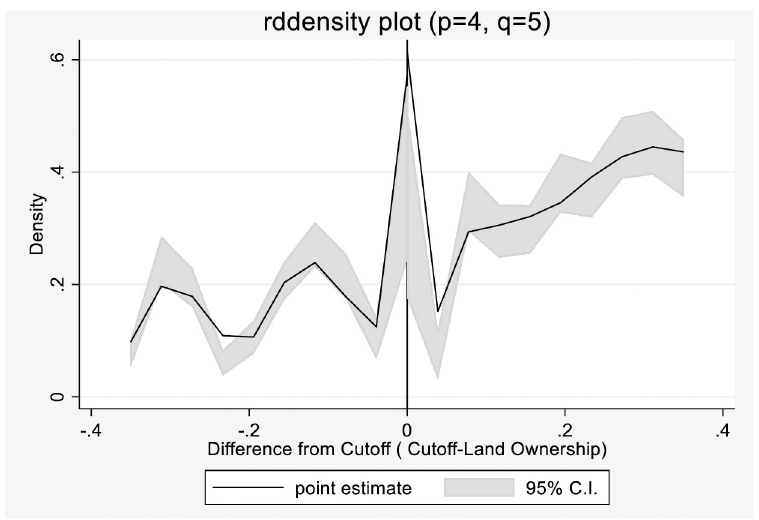
Fig 3. Checking discontinuity in the running variable.